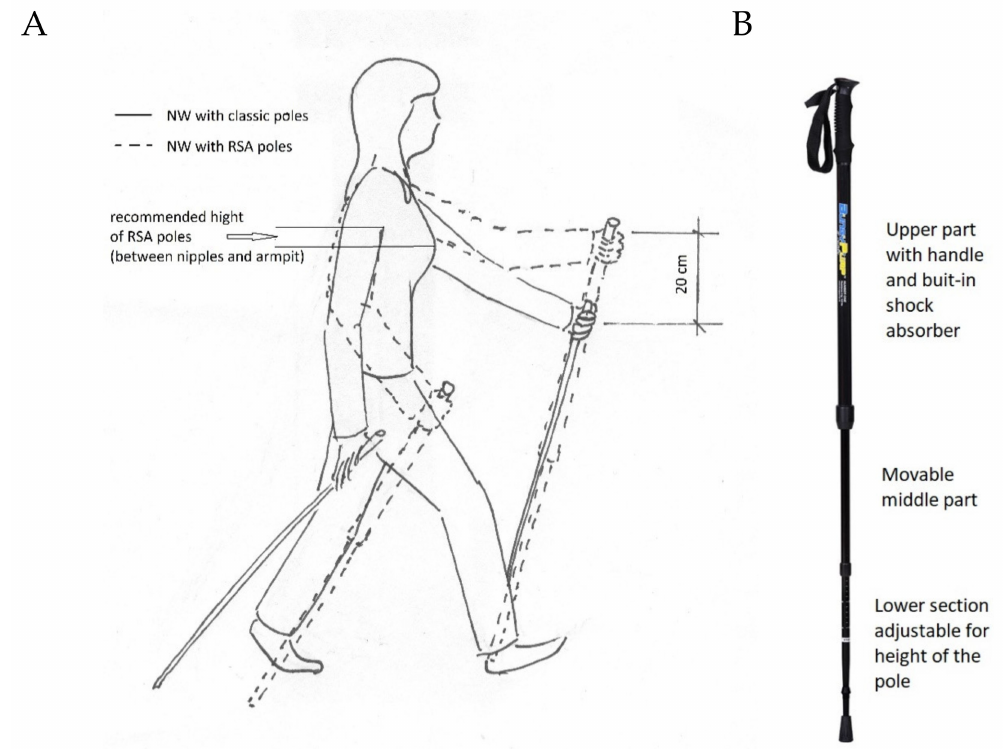
Figure 3. Correct position of upper limbs during Nordic walking with classic and resistant shock absorber (RSA) poles ( A ) and structure of RSA pole ( B